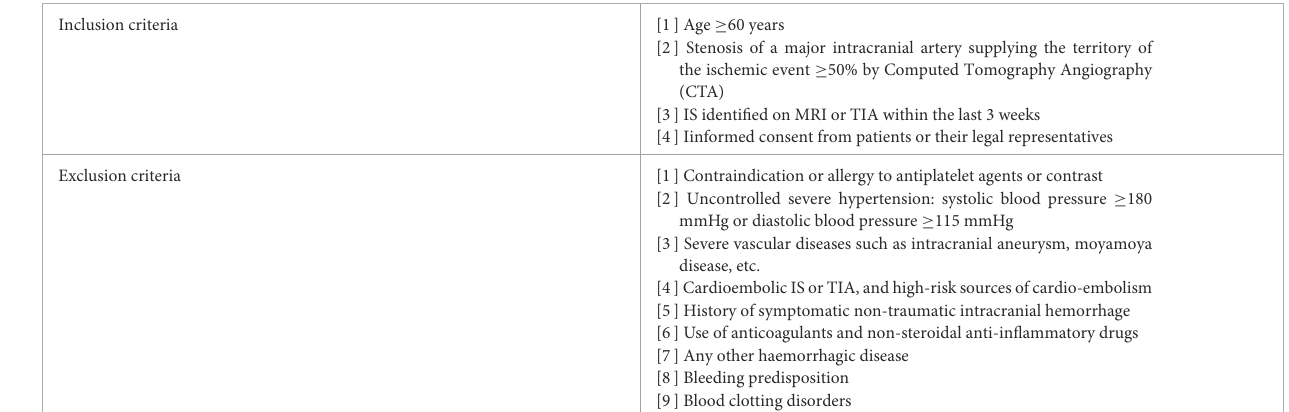
TABLE 1 Inclusion and exclusion